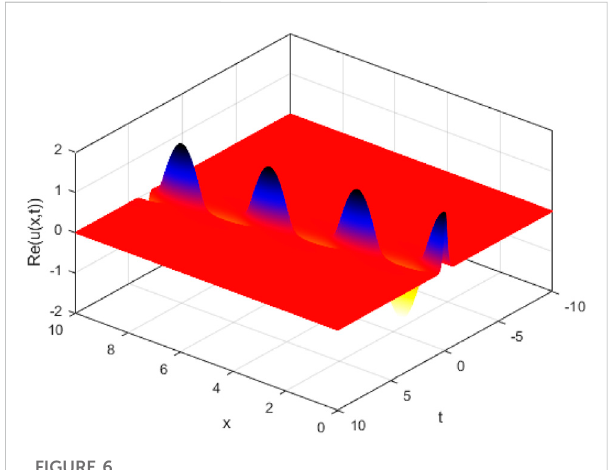
FIGURE 6 3D plot for solution (3.4) with k = 1.5, c = 1.9, and γ = 2.